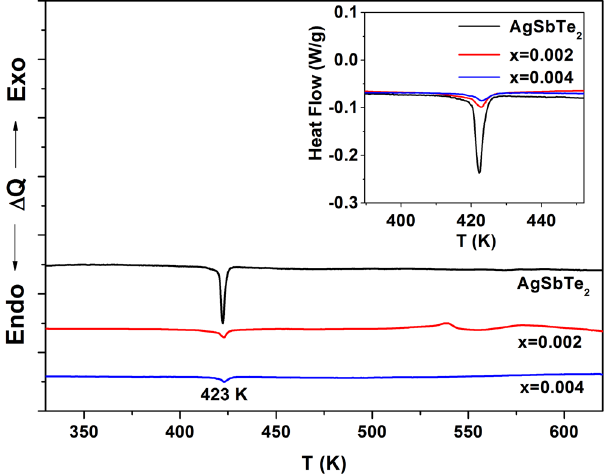
Figure 3. Differential scanning calorimetry (DSC) curves for the Ce-doped AgSb 1 − x Ce x Te 2 samples; the peak at 423 K corresponds to the phase transition peaks from α -Ag 2 Te to β -Ag 2 Te. The intensity decreased with Ce doping, which is related with the decreased Ag 2 Te ratio. (The sample mass is 50